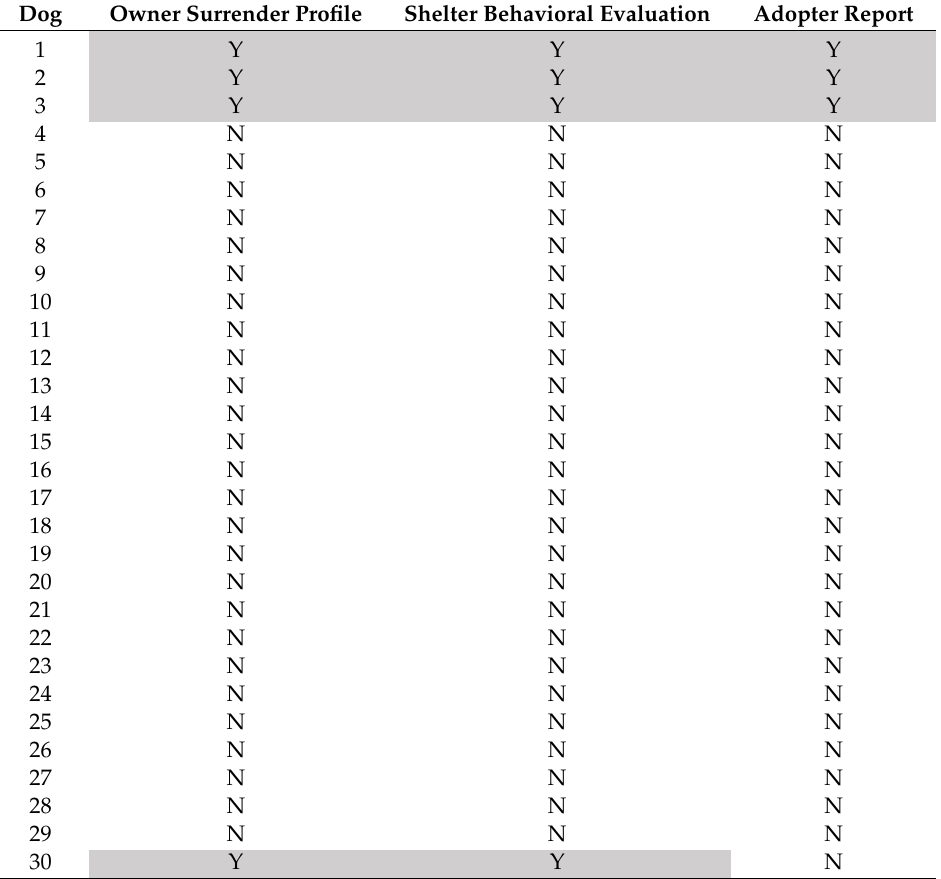
Table A1. A comparison of resource guarding status based on owner surrender profiles, shelter behavioral evaluations, and adopter reports for 44 dogs. Shaded cells with a Y (for Yes) indicate resource guarding was reported by surrendering owner, shelter evaluator, or adopter. Unshaded cells with an N (for No) indicate no resource guarding was